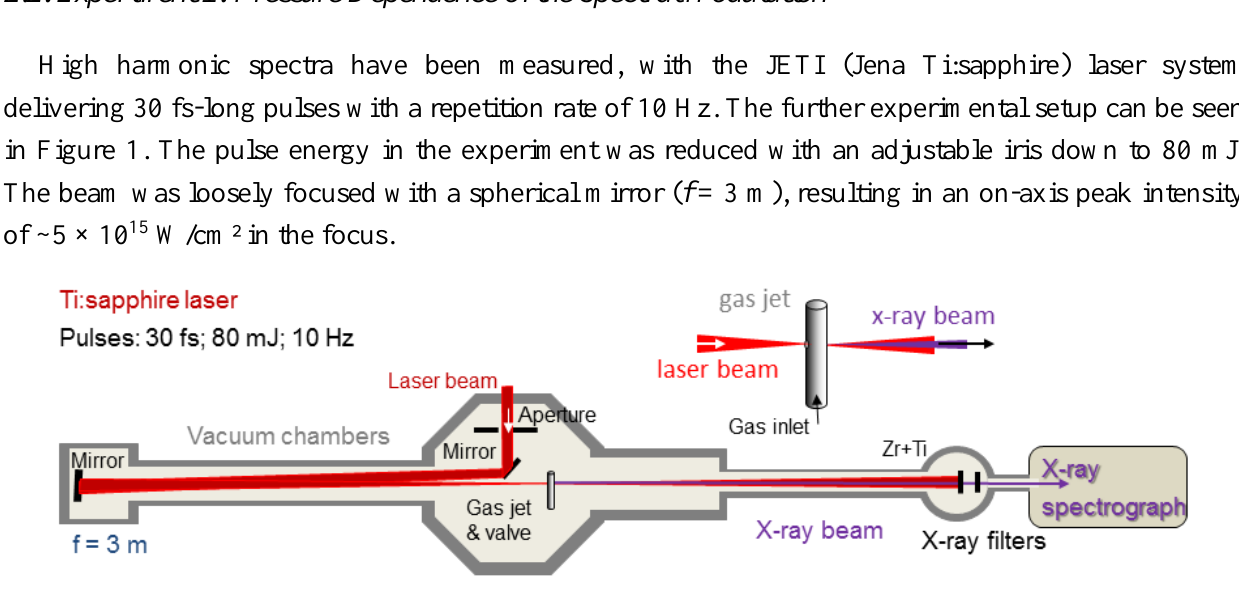
Figure 1. Experimental setup with the 10-Hz Ti:sapphire laser system. For the details, see the